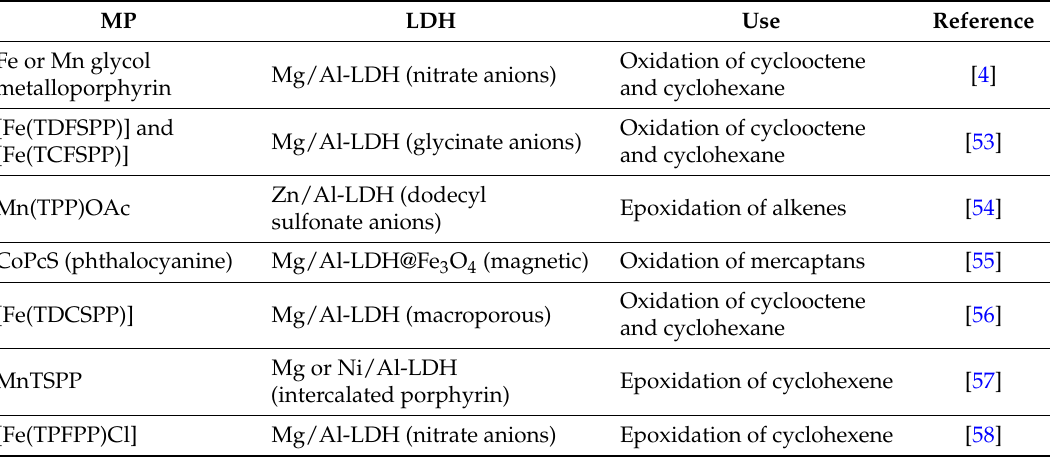
Table 1. Summary of the main MP immobilized in LDH in Section